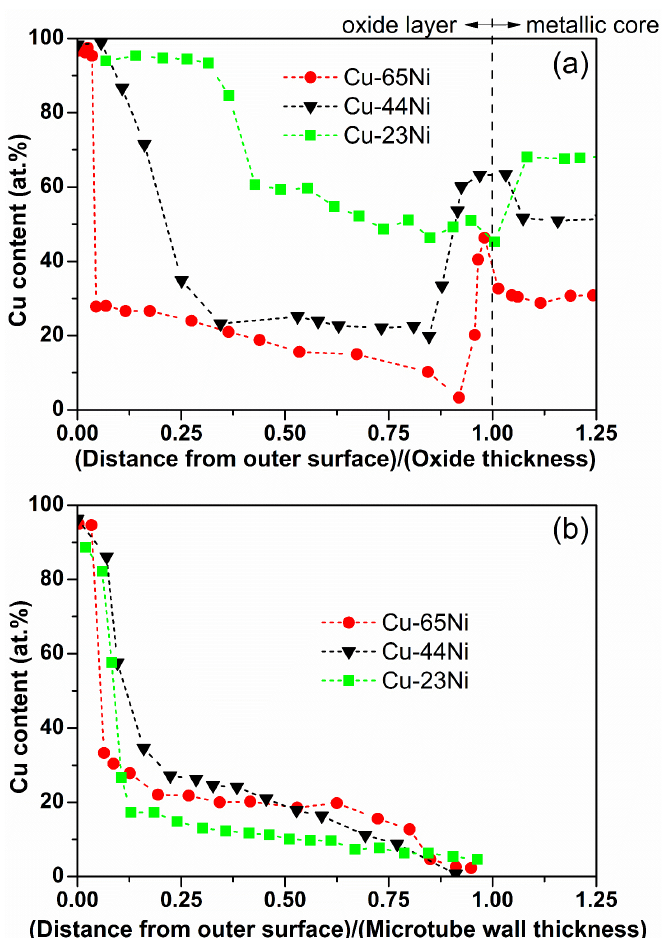
Figure 5. Energy Dispersive X-ray analysis (EDX) composition profiles of Cu as a function of the distance from the outer surface for the partially oxidized wires ( a ) and the reduced metallic microtubes ( b ). Red circles, black triangles and green squares refer to Cu-65Ni, Cu-44Ni and Cu-23Ni samples, respectively. Dashed lines are a guide to the eye.